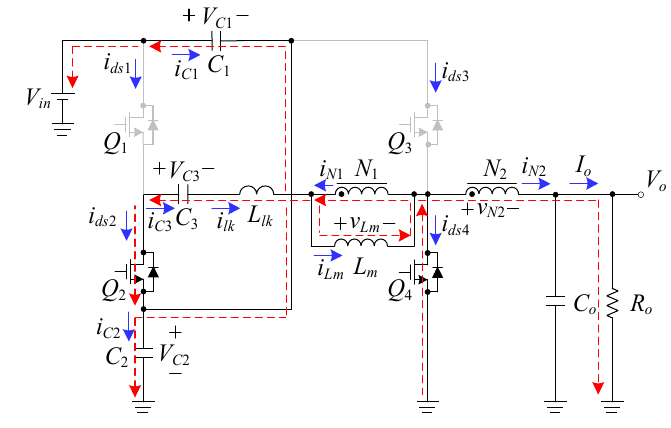
Figure 8. Current flow during state 5.